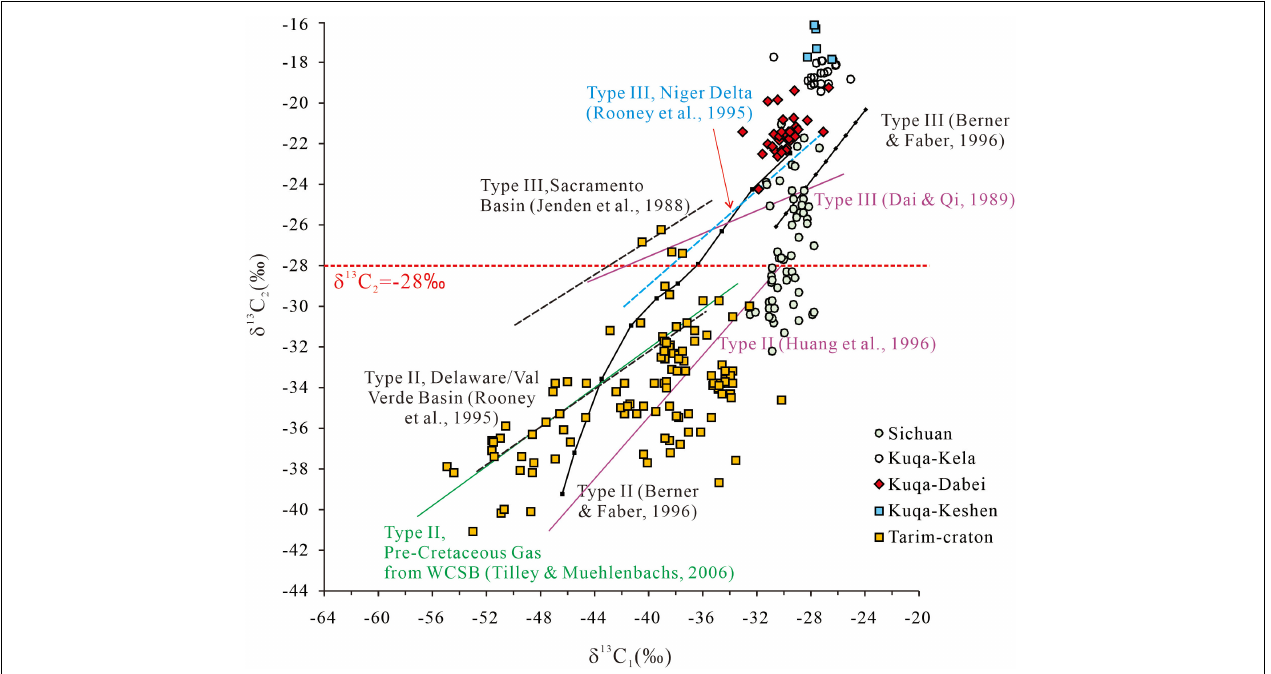
FIGURE 6 | δ 13 C 1 vs. δ 13 C 2 cross-plot of gases from Dabei, Keshen and Kela2 gas fields in the Kuqa depression, craton area of Tarim Basin, and Sichuan Basin. Also shown are published maturity trends of type II kerogen (Rooney et al., 1995; Huang et al., 1996; Tilley and Muehlenbachs, 2006) and type III kerogen (Jenden et al., 1988; Dai and Qi, 1989; Rooney et al., 1995; Berner and Faber, 1996). Data source see section “Samples and Methods” in the text.